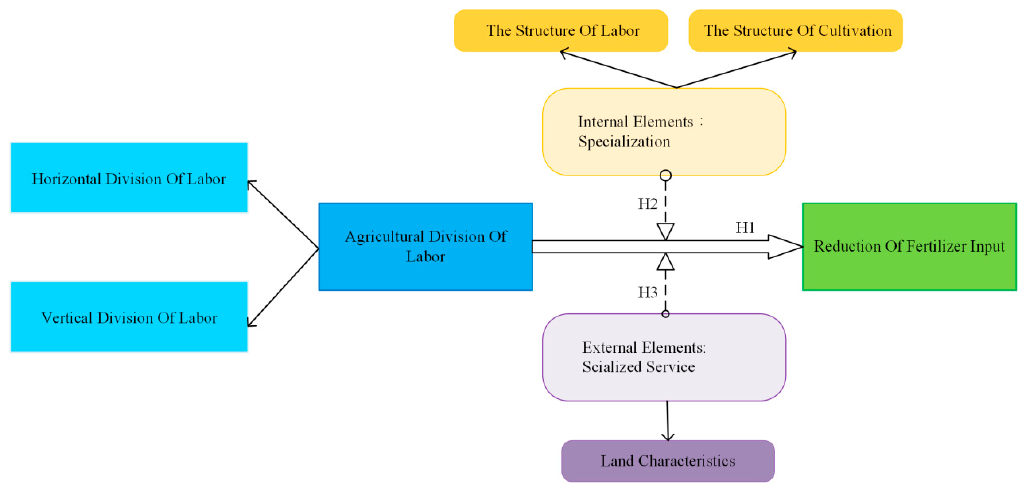
Figure 1. Mechanism for the impact of agricultural division of labor on fertilizer reduction application.